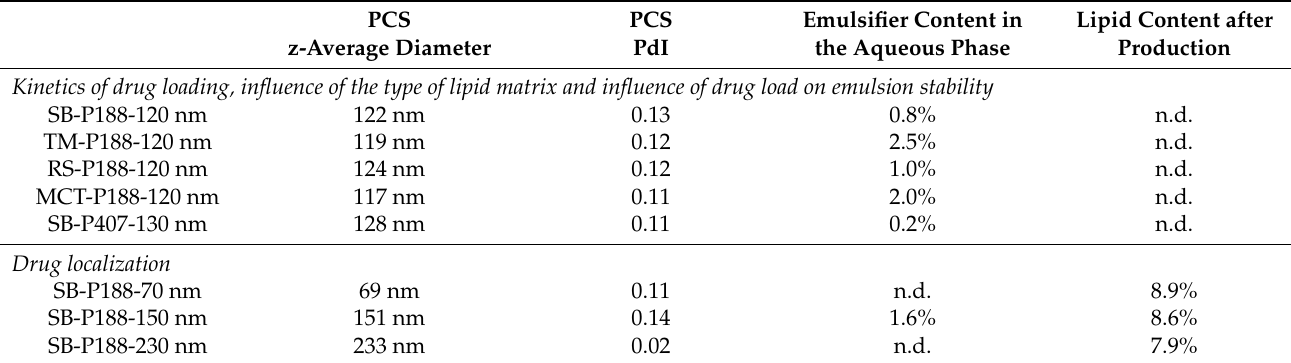
Table 4. Particle size and emulsifier content in the aqueous phase of